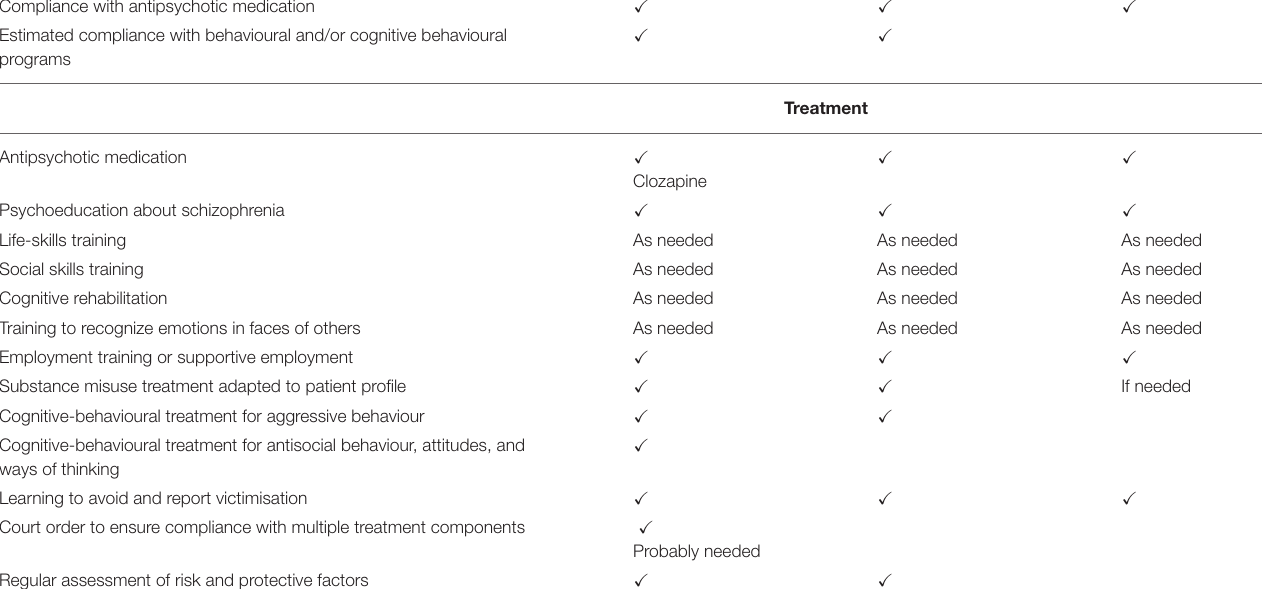
Aggressive behaviour since childhood